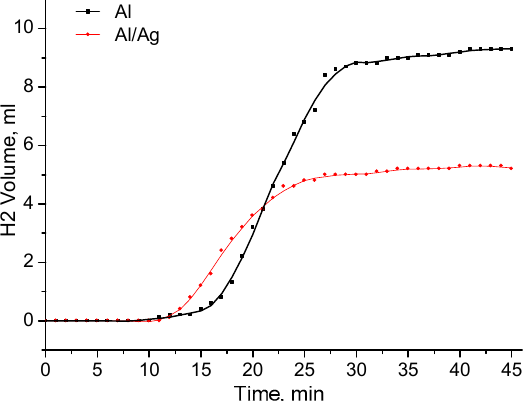
Figure 4. Hydrogen release kinetics during water oxidation of Al (black curve) and Al/Ag nanoparticles (red curve) fixed at the alumina ceramics surface.